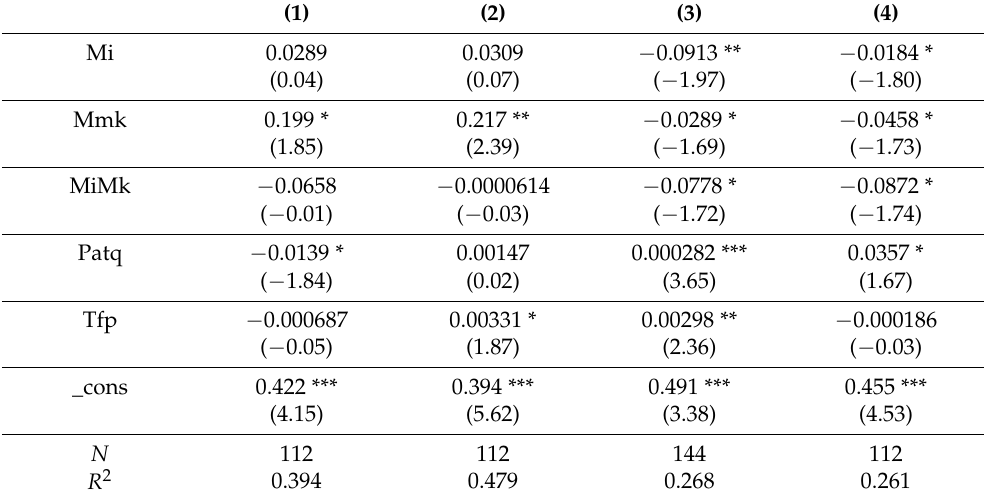
Table 7. Heterogeneity